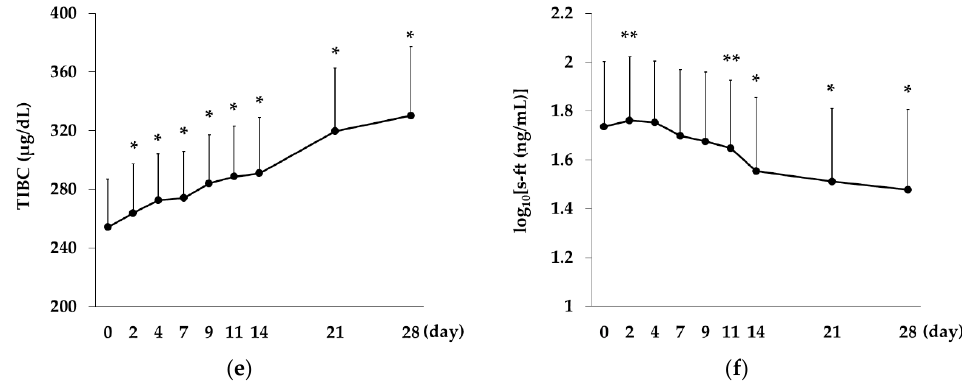
Figure 4. Changes over time in CHr, hepcidin levels and iron-related indices in the Rox group. ( a ) CHr showed a significant increase on Day 4 ( p < 0.01 vs. Day 0). ( b ) Log 10 (hepcidin) showed significant decreases on Day 2 and all time points thereafter ( p < 0.01 on Days 2, 4, 7, 11, 14, 21, and 28 vs. Day 0). ( c ) s-Fe showed a significant increase on Day 2 ( p = 0.02 vs. Day 0) and a significant decrease on Day 7 ( p < 0.01 vs. Day 0). ( d ) TSAT showed significant decreases on Days 7, 14, 21, and 28 ( p < 0.01 vs. Day 0). ( e ) TIBC showed significant increases on Day 2 and all time points thereafter ( p < 0.01 on Days 2, 4, 7, 11, 14, 21, and 28 vs. Day 0). ( f ) Log 10 (s-ft) showed significant decreases after Day 11 ( p = 0.02 on Day 11; p < 0.01 on Days 14, 21. and 28 vs. Day 0). One-way post-hoc tests. The data are represented as mean ± SD. *, p < 0.01; **, p < 0.05.